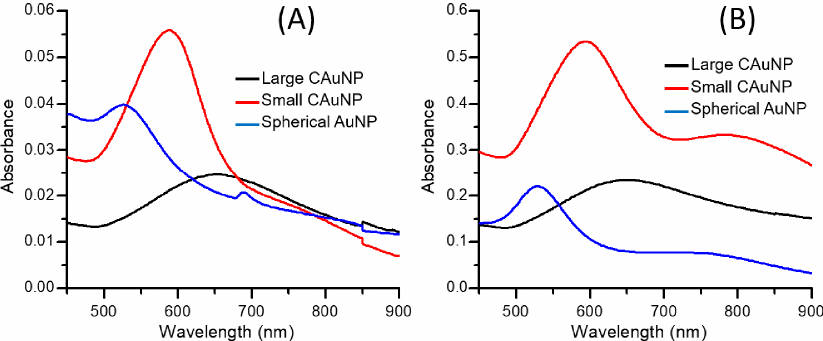
Figure 2. UV-Vis spectra of CAuNPs and spherical AuNPs ( A ) before and ( B ) after concentration. The light paths were 10 mm for A and 1 mm for B, respectively. The concentrations were 0.1 mM/Au before centrifugation and 5 mM/Au after centrifugation.